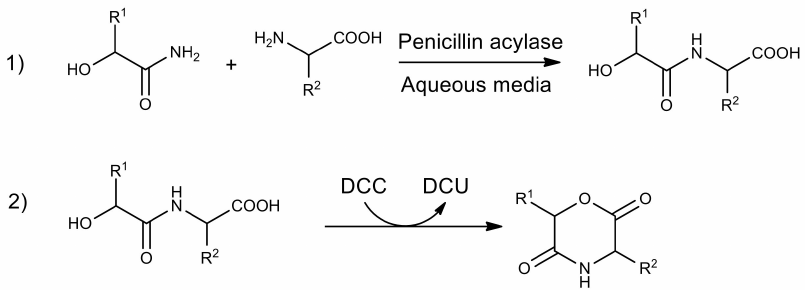
Figure 18. Chemoenzymatic synthesis of 2,5-diketomorpholine derivatives. R 1 —hydroxy acid side chain radical, R 2 —amino acid side chain radical, DCC—N,N’-dicyclohexylcarbodiimide, DCU— N,N’-dicyclohexylurea.